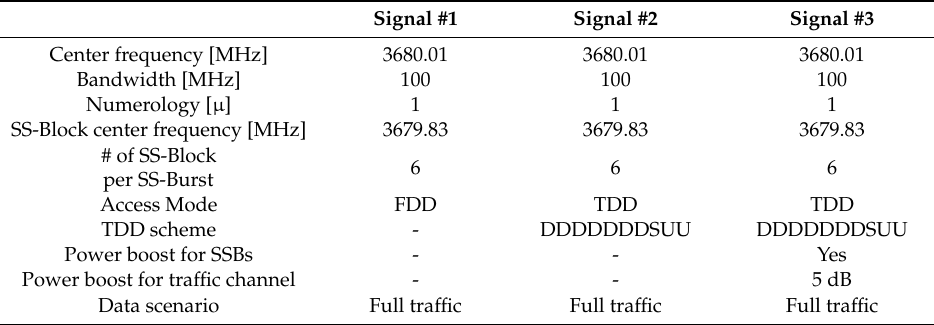
Table 1. Characteristics of the 5G